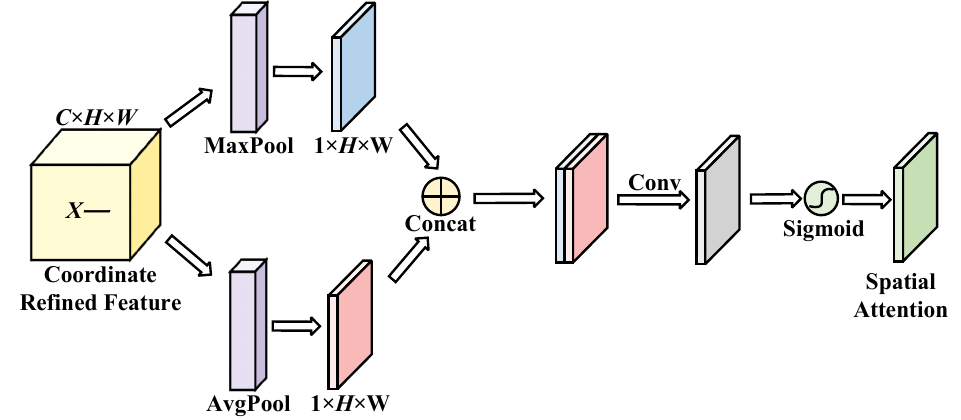
Figure 5. Architecture of the SAM.